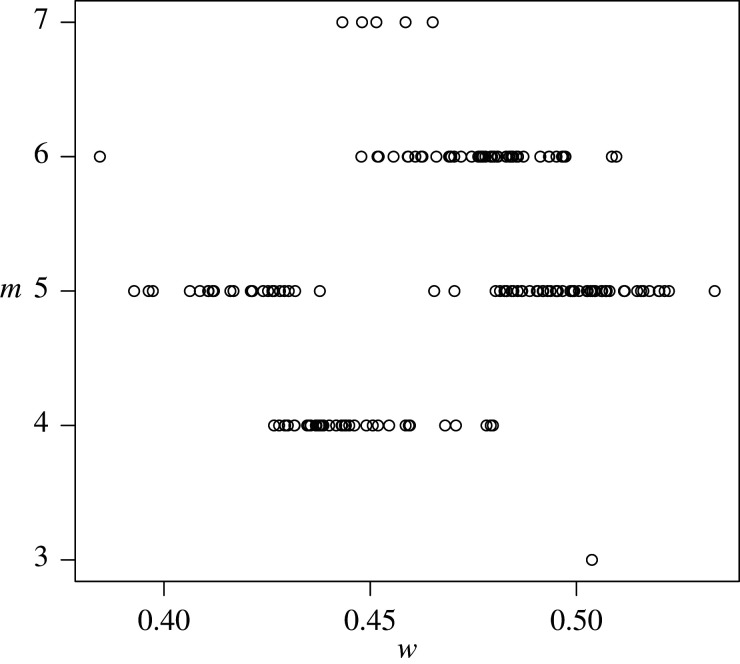
Estimates of (w, m) for accepted tests at hc = 0.015.